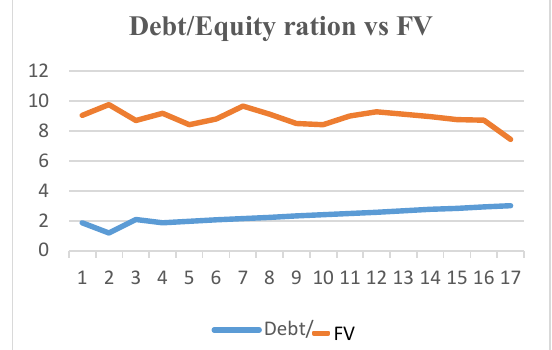
Fig. 2. Trend of Debt-Equity for Food Processing Firms in India